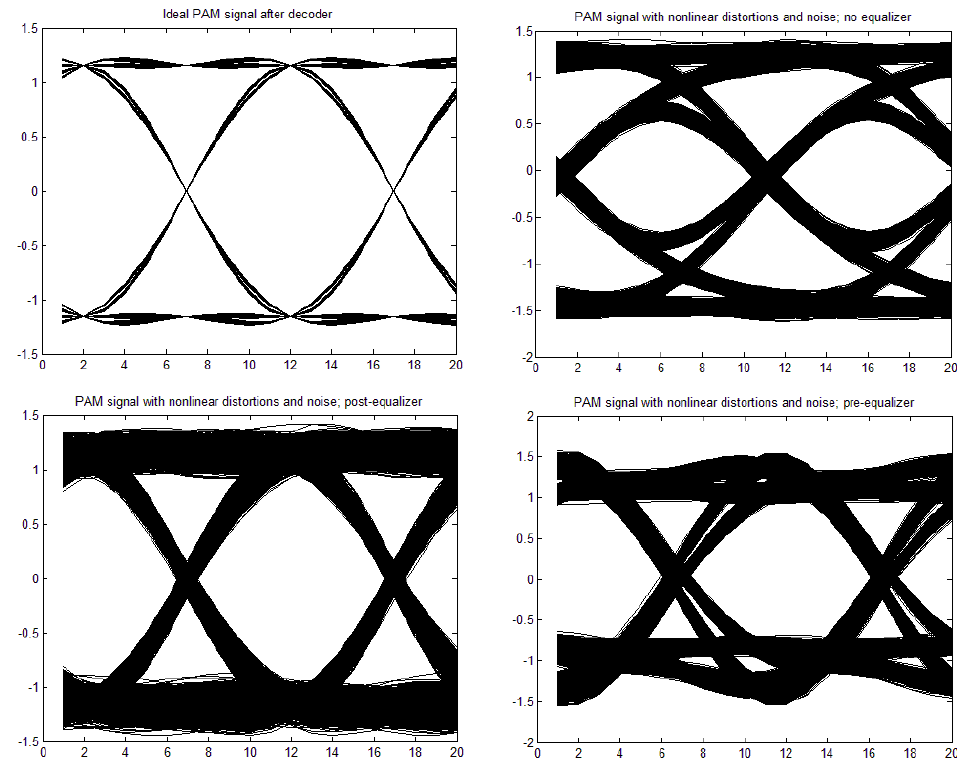
Figure 5. Eye patterns for PAM-2. Moderate nonlinearity: [1, − 0.1, 0.05, 0.02], and α = 1, SNR = 20 dB, and τ = 0.3T.